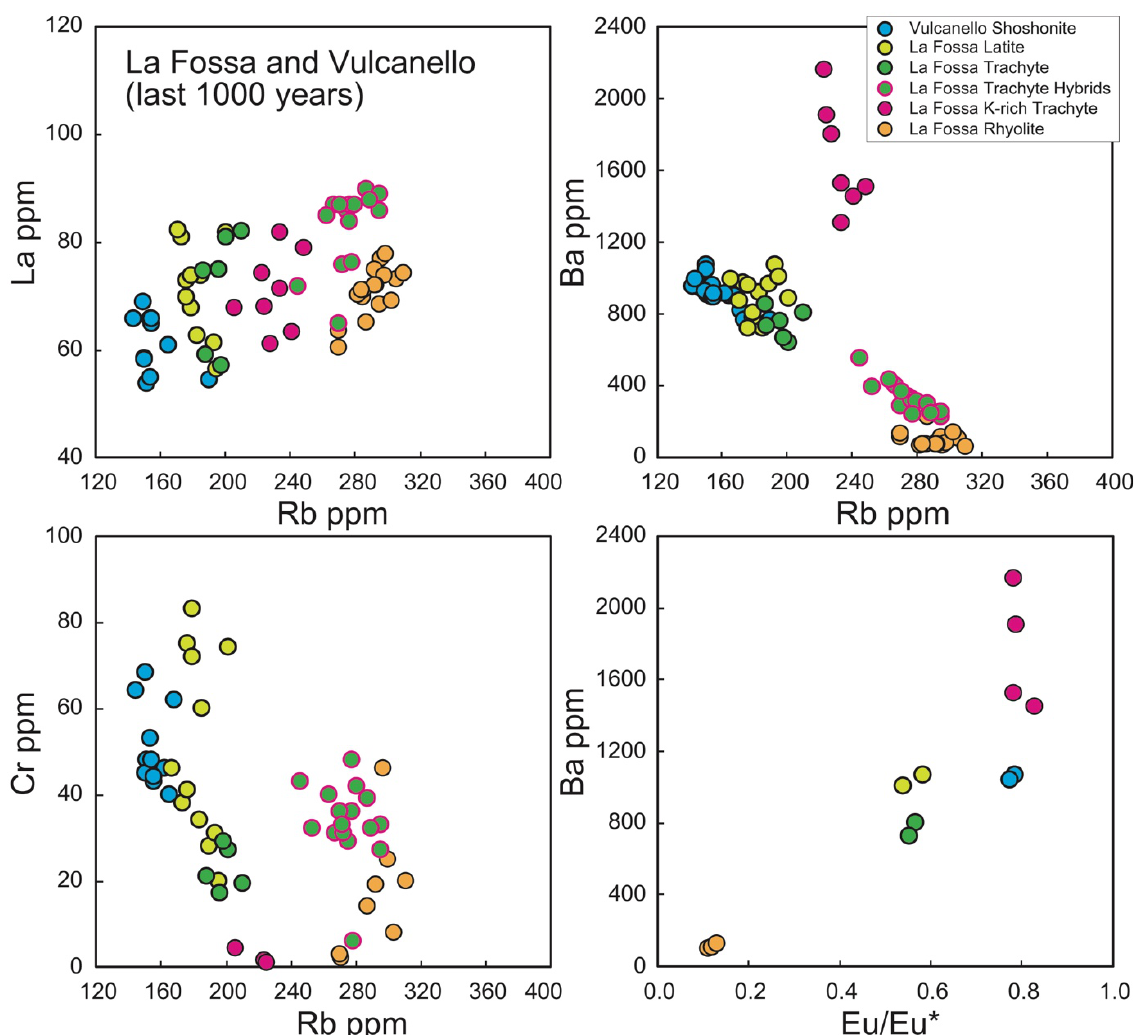
Figure 3. Whole-rock trace elements variation diagrams of the investigated products. Eu anomaly (Eu/Eu* = Eu N /(Sm N xGd N ) 1/2 ) has not been calculated for the hybrid trachytes due to the lack of Gd data. See the Supplementary Table S2 for the complete dataset. Literature data source as Figure 2.